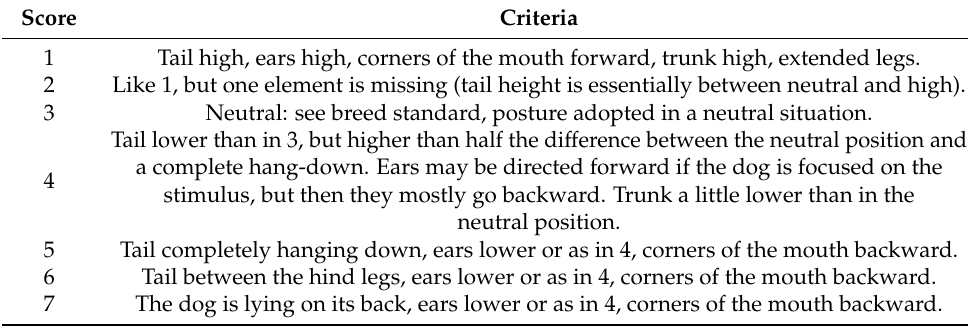
Table A4. Criteria for scoring the different behavioural strategies of the dogs after undergoing different stimuli while carrying out the Socially Acceptable Behavioural test. Strategy Description of the Behavioural Elements of the SAB 1 Eye blinking, ear twisting, tongue flicking, swallowing, lip licking and yawning. 2 Raising leg, shaking, looking away, crouching, restless eye and head movements. 3 Shrinking back quickly or slowly, walking away, recoiling or retreating. 4 Fleeing in >50% of the subtest. Short hard barking, piloerection, staring, snarling, growling, wagging a stiff tail, showing teeth and stiffening. Biting, snapping or lunging (without signals of play behaviour). 7 Looking at the owner, moving closer next to or behind the owner in a lower